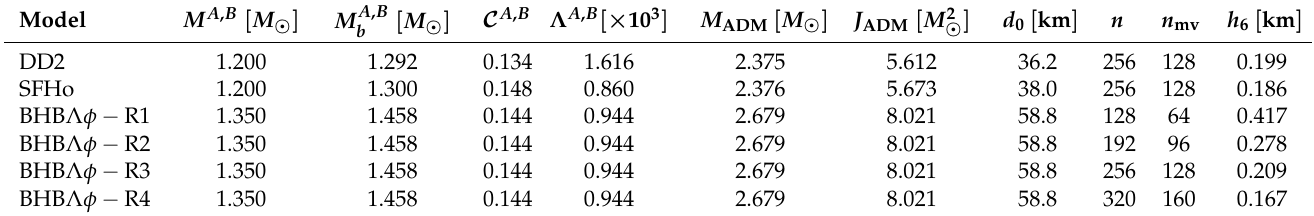
Table 2. Binary neutron star simulations. From left to right, the columns read: simulation name, gravitational mass of the stars ( A , B ) in isolation, baryonic mass of the stars, compactness of the stars, tidal deformability of stars, ADM mass and ADM angular momentum of the BNS at the beginning of the simulation, initial coordinate distance between the stars, number of points per direction on the static levels, number of points per direction on the moving levels, and grid spacing at the finest